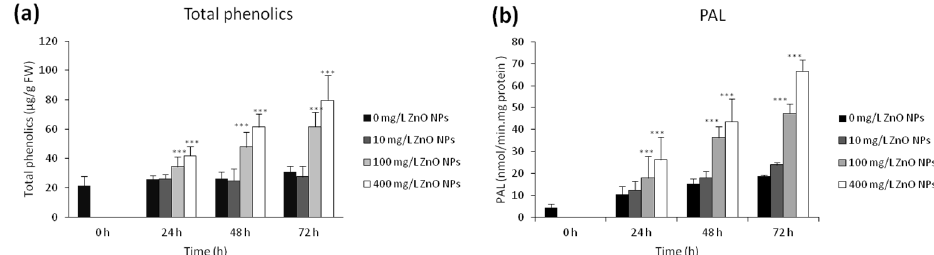
Figure 6. Content of total polyphenols (µg/g FW) ( a ) and phenylalanine ammonia-lyase (PAL) ( b ) activity (pcat/g FW) in control and BY-2 cell treated with 10, 100, and 400 mg/L ZnO NPs. * indicates a significant difference between the BY-2 cells treated with ZnO NPs and the corresponding control (untreated) BY-2 cells at p < 0.05, ** indicates a significant difference between the BY-2 cells treated with ZnO NPs and the corresponding control (untreated) BY-2 cells at p < 0.01, *** indicates a significant difference between the BY-2 cells treated with ZnO NPs and the corresponding control (untreated) BY-2 cells at p < 0.001. Bars represent standard deviations.